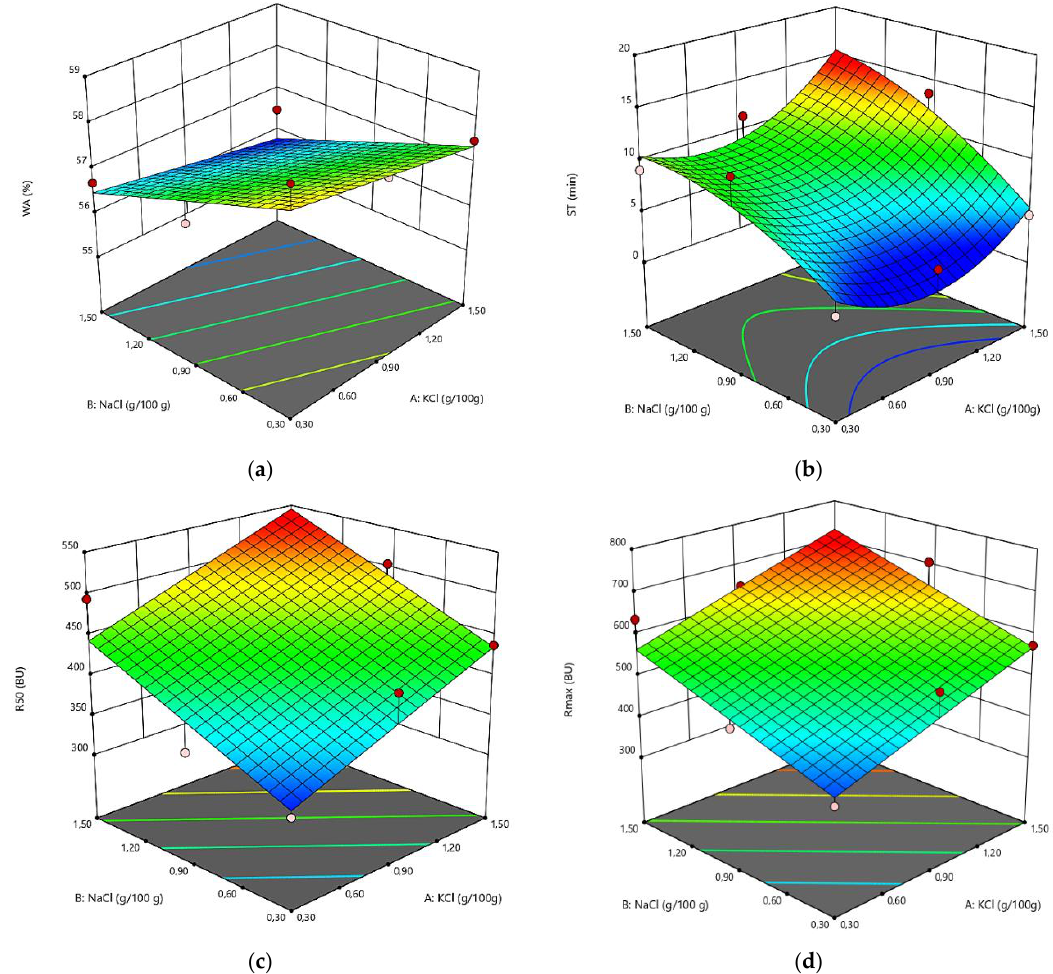
Figure 1. The graphical representations of the Farinograph and Extenograph parameters: ( a ) water absorption (WA); ( b ) stability of dough (ST); ( c ) resistance to extension up to 50 mm (R 50 ); ( d ) maximum resistance to extension (R max ).